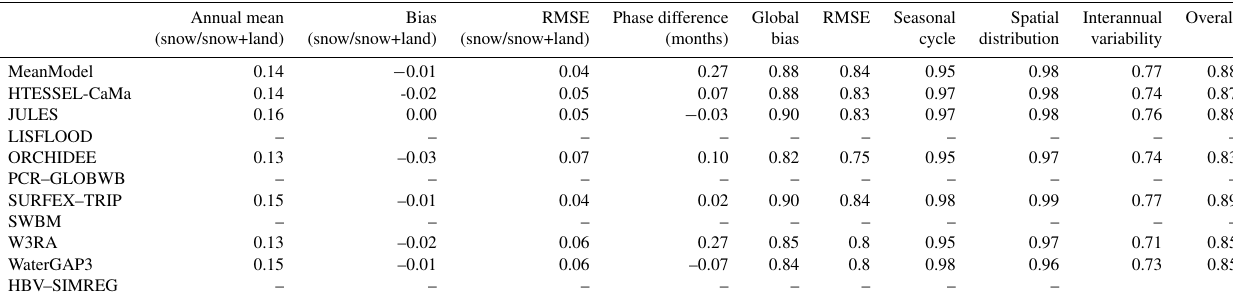
Table B5. Diagnostic summary for snow cover: model vs.